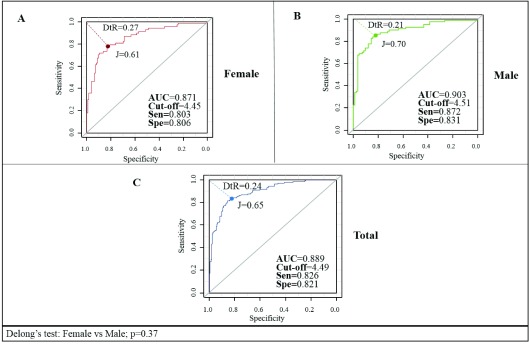
Receiver Operating Characteristic curves for the triglyceride-glucose index in the reference population by gender, in Maracaibo city, Venezuela.DtR, Distance to ROC; J, Youden Index; AUC, are under the curve; sen, sensitivity; spe, specificity.